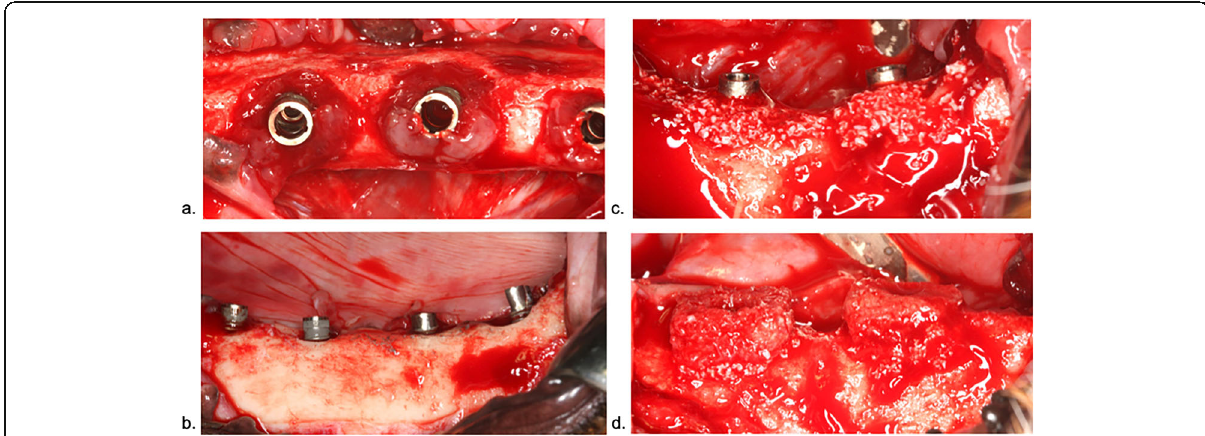
Fig. 1 Surgical procedures. a Ligature-induced chronic-type peri-implantitis defects after phase 3. b Supra was randomly allocated to either the application of EB or implantoplasty (two implants at the right). c At all implant sites, the intrabony defect component was homogeneously filled with NBM. d EB blocks were applied over the exposed implants following preparation of a central core (Ø 3.8 mm). NBM and EB were randomly soak-loaded with rhBMP-2 or sterile